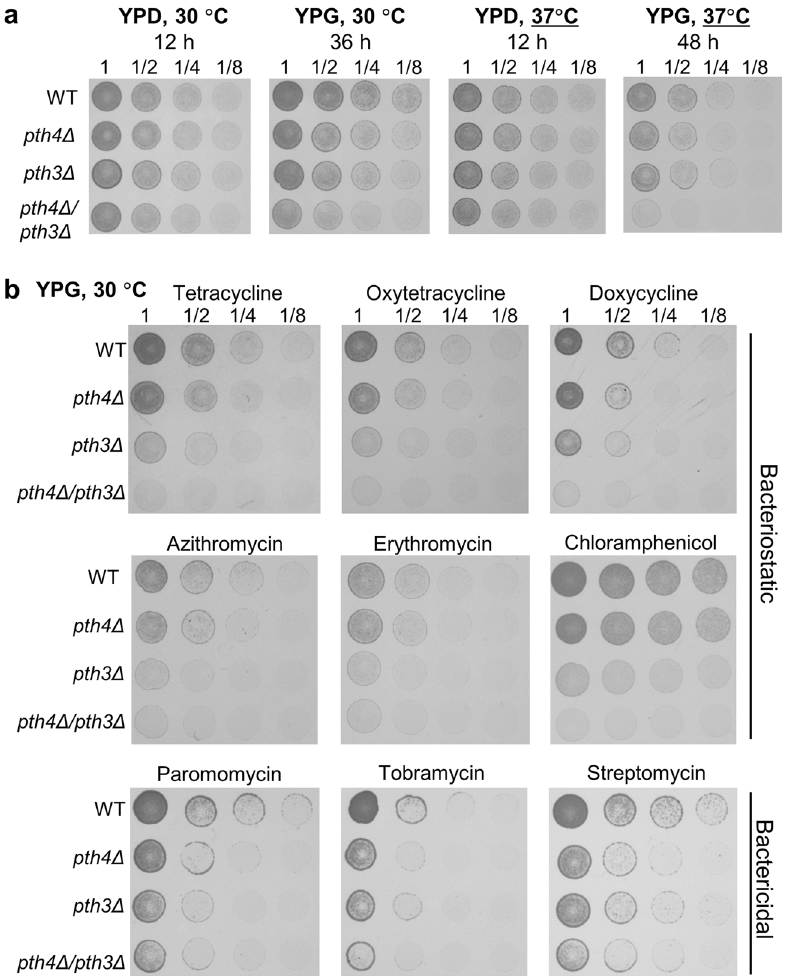
Fig. 1 Susceptibility of PTH4- and/or PTH3 -de fi cient mutants of S. cerevisiae to temperature and antibiotics. a The wild type (WT), pth4 Δ , pth3 Δ , and pth4 Δ pth3 Δ were serially diluted and then spotted onto YPD and YPG plates containing glucose and glycerol as a carbon source, respectively. Plates were incubated at 30 °C or 37 °C for the indicated hours. The results of all of the spotting assays in the present study are shown for one experiment representative of at least three independent experiments. b The four strains were serially diluted and then spotted onto YPG plates containing the following antibiotics, with the concentration shown in parentheses ( µ g/mL): tetracycline (100), oxytetracycline (200), doxycycline (100), azithromycin (75), erythromycin (20), chloramphenicol (1000), paromomycin (100), tobramycin (100), and streptomycin (1000). Plates were incubated at 30 °C for 48 h (tetracycline, oxytetracycline, and doxycycline) or 72 h (the others). Corresponding images of cells grown on YPD plates for 24 h are shown in Supplementary Fig.